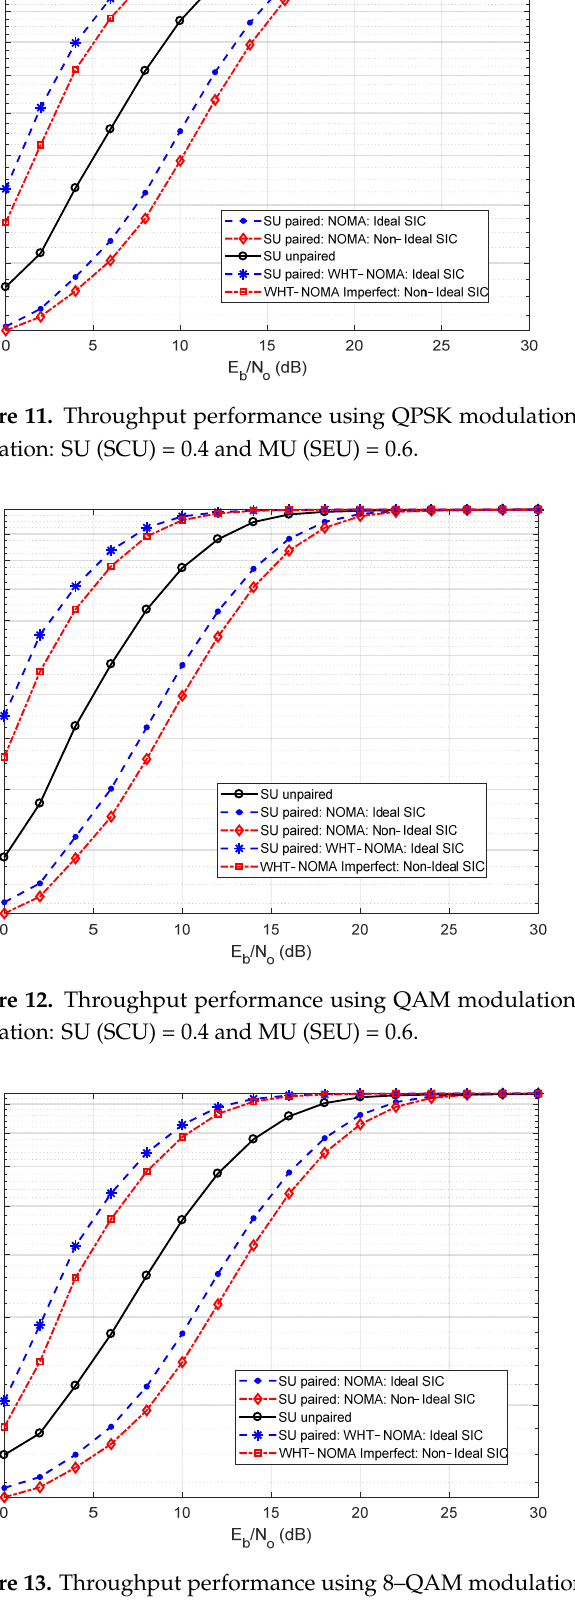
Figure 13. Throughput performance using 8–QAM modulation; NOMA vs. WHT–NOMA, power allocation: SU (SCU) = 0.4 and MU (SEU) = 0.6.